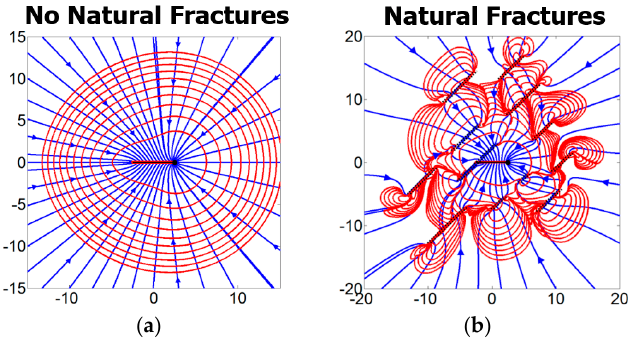
Figure 1. Plan view of reservoir showing streamlines (blue) and time-of-flight contours (red) toward a central vertical well. ( a ): Single well with a single hydraulic fracture. ( b ): Single well with multiple natural fractures in reservoir. After Van Harmelen and Weijermars [9].